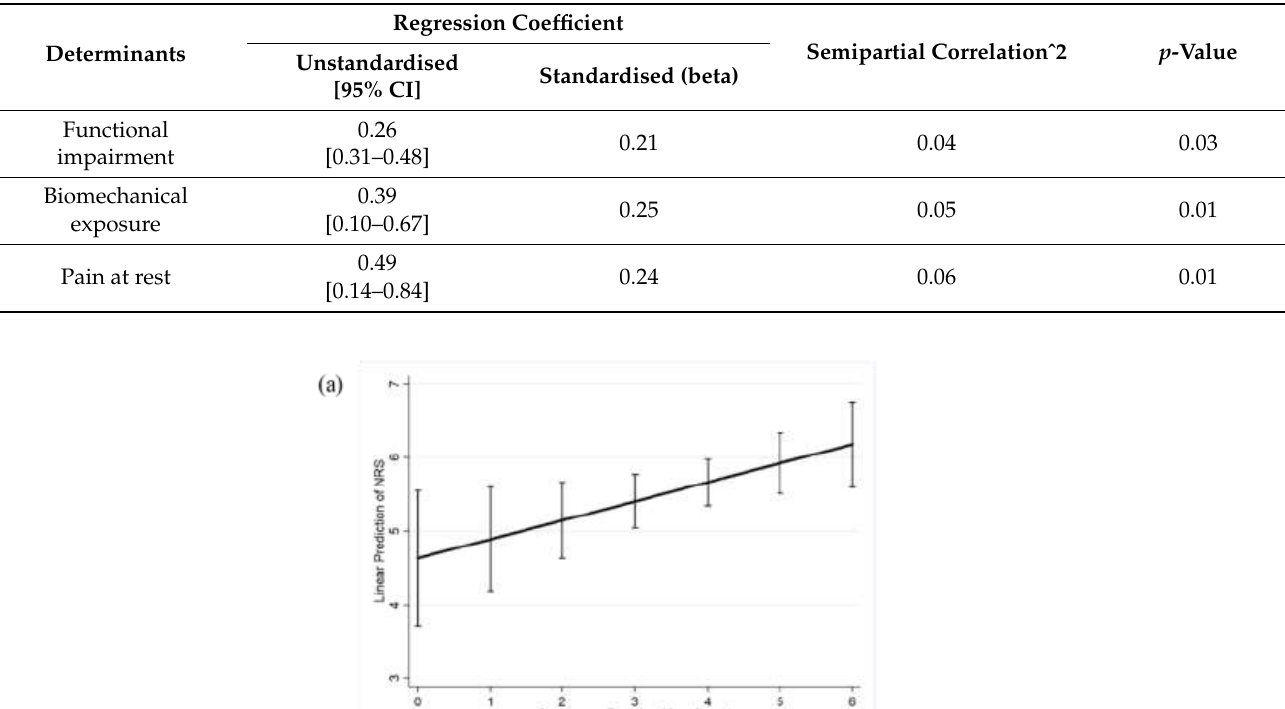
Table 3. Estimates of determinants of multiple regression of pain intensity on the NRS in dance teachers (n = 110).